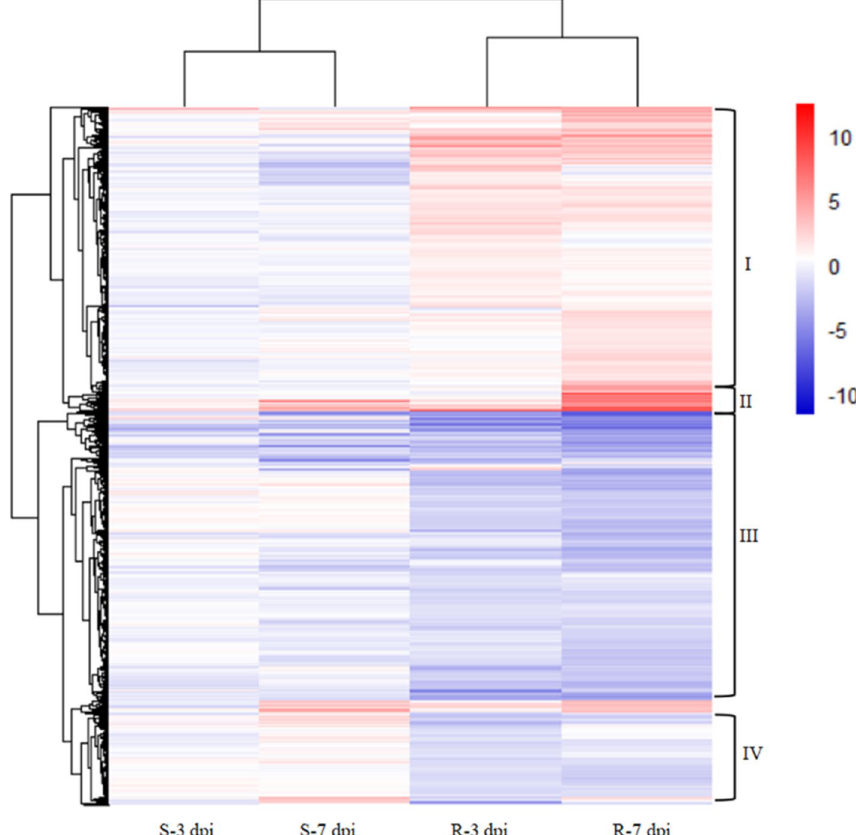
Figure 3. Expressions of differentially expressed genes in resistant and susceptible cultivars. Each column represents the log 2 (In/M) at indicated times, where In and M are read count values of the gene in inoculated and mock samples, respectively. Red and blue represent upregulated and downregulated genes, respectively. The darker the color, the higher is the degree of upregulation or downregulation. Heatmap was generated in R (v 2.15.3) with the ComplexHeatmap package (v 2.11, https ://bioco nduct or.org/packa ges/relea se/bioc/html/Compl exHea